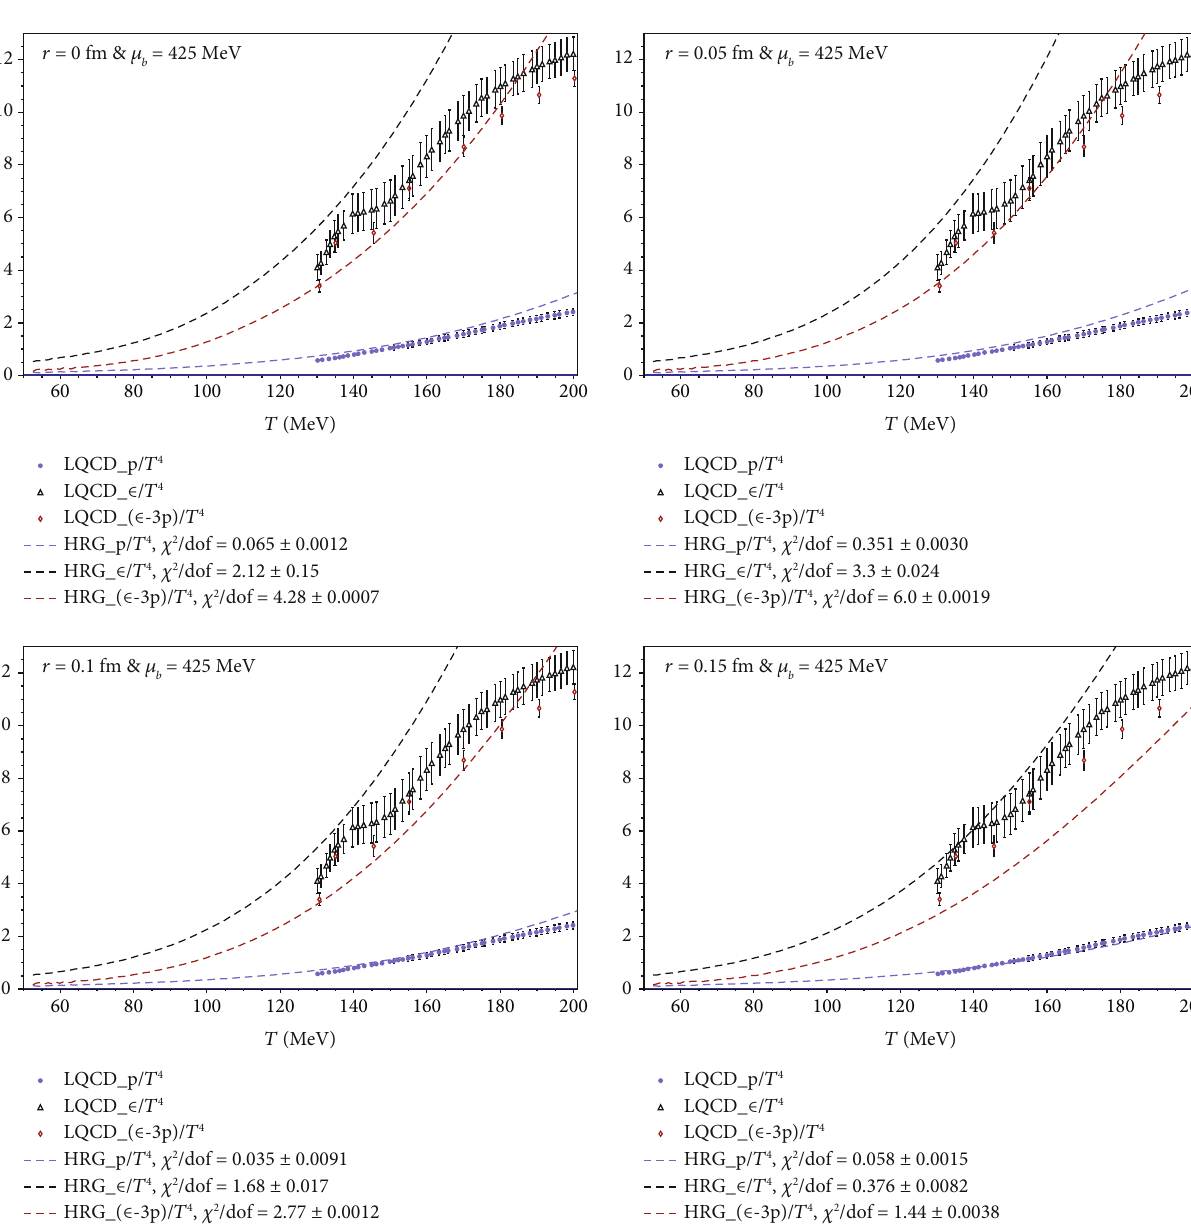
Figure 4: The same as in Figure 1 but at μ